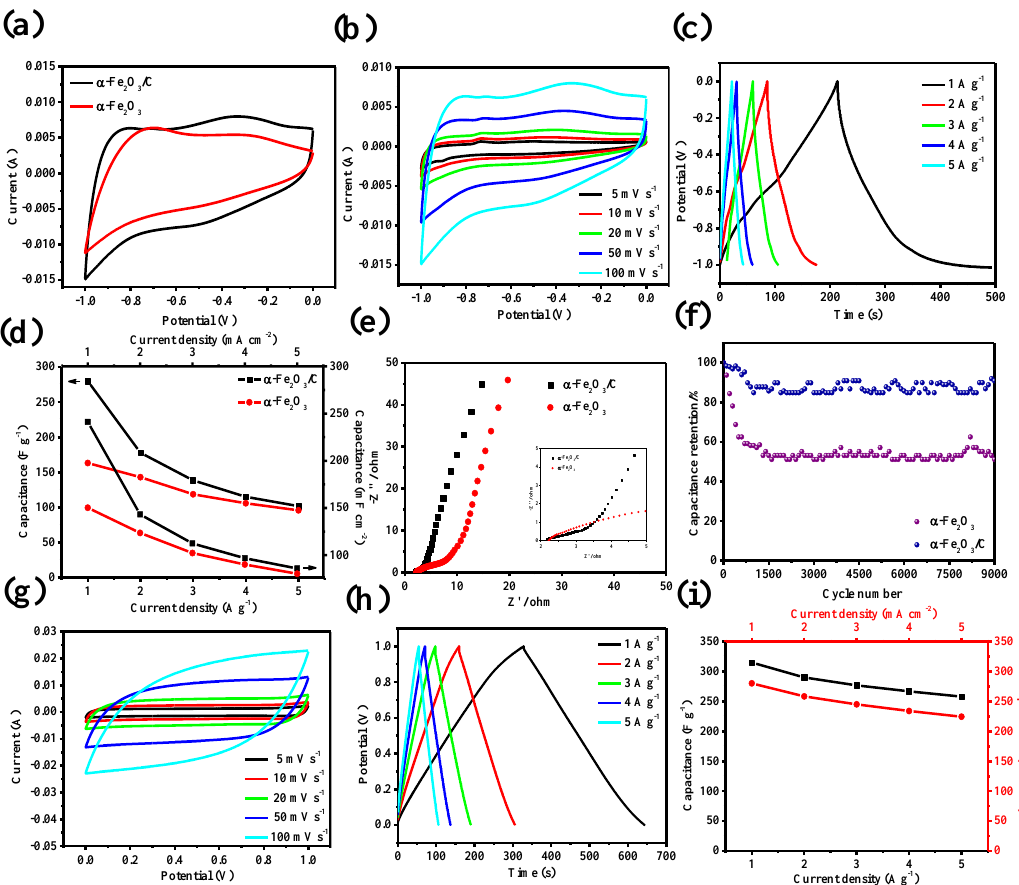
Figure 3. ( a ) CV curves of α-Fe 2 O 3 nanowire arrays and α-Fe 2 O 3 @C nanowire electrode at a scan rate of 100 mV s −1 ( b ) CV curves of α-Fe 2 O 3 nanowire arrays electrode at different scan rates ( c ) GCD curves of α-Fe 2 O 3 @C nanowire electrode at varied current density ( d ) The specific mass capacitance and area capacitance of α-Fe 2 O 3 nanowire arrays and α-Fe 2 O 3 @C nanowire electrodes calculated from CGD curves ( e ) Nyquist plots for α-Fe 2 O 3 nanowire arrays andα-Fe 2 O 3 @C nanowire electrodes ( f ) Cycle performance of α-Fe 2 O 3 nanowire arrays andα-Fe 2 O 3 @C nanowire electrode at 5 A g −1 for 9000 cycles ( g ) CV curves of MnO 2 nanosheets electrode at different scan rates ( h ) GCD curves of MnO 2 nanosheets electrode at varied current densities ( i ) The specific mass capacitance and area capacitance of MnO 2 nanosheets electrode calculated from CGD curves.